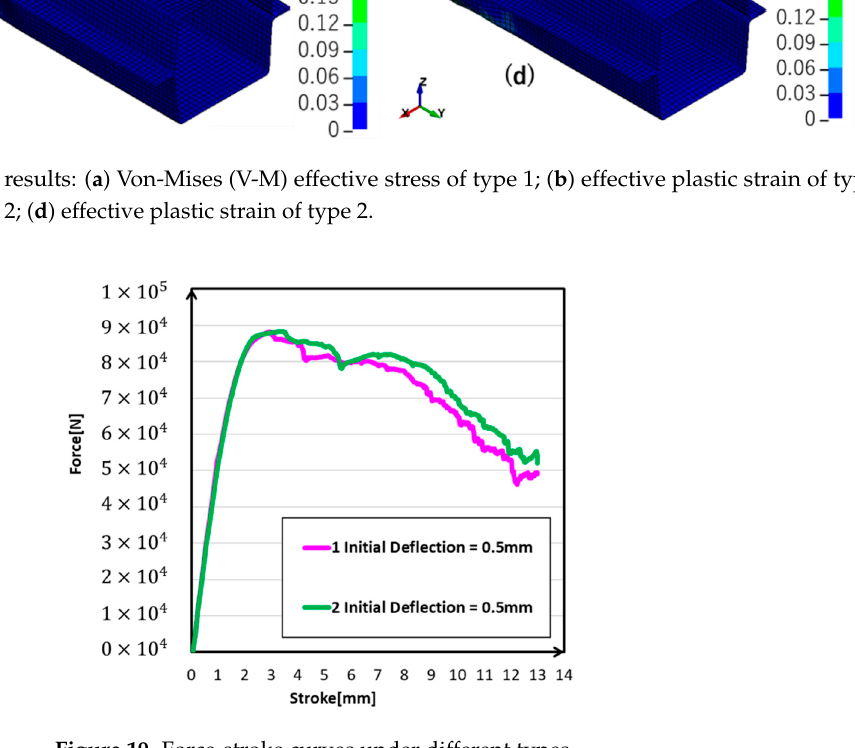
Figure 19. Force-stroke curves under different types.